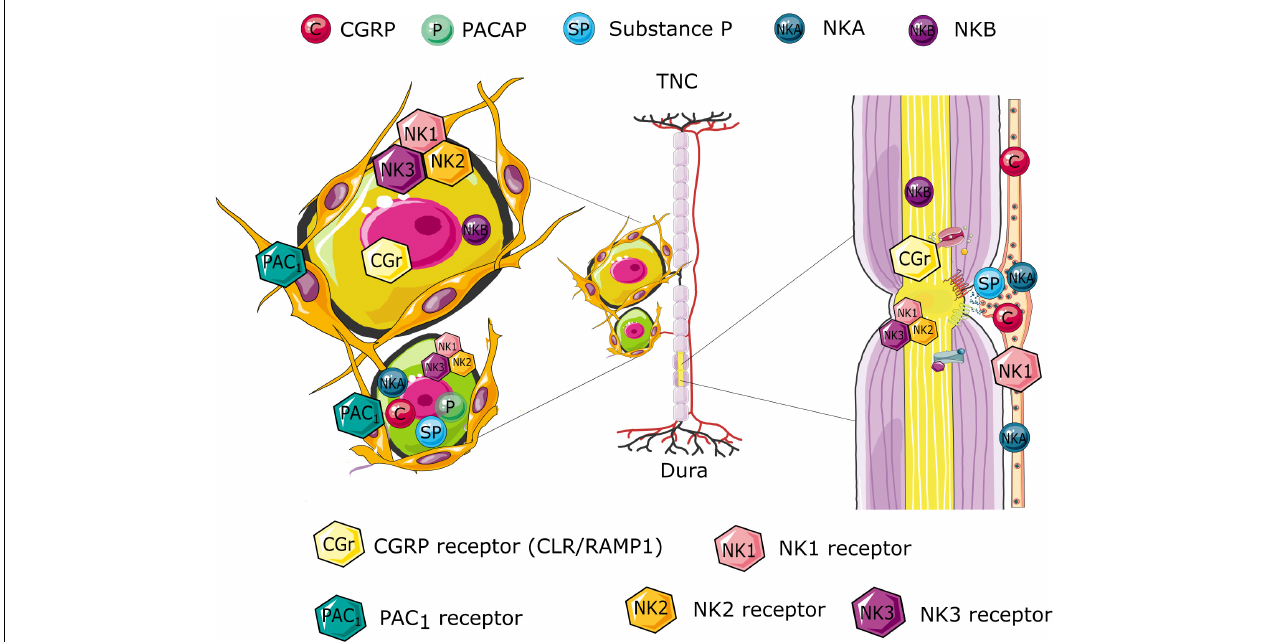
FIGURE 2 | Schematic illustration of the differential distribution of the CGRP, pituitary adenylyl cyclase-activating polypeptide (PACAP), and Neurokinin signaling compounds in the trigeminal system. The illustration suggests possible site of origin if the various peptides and their associated release. Further, the receptor expression highlights possible receptor targets, following the peptide release. The expression is based on immunology findings from the following studies (Edvinsson et al., 2019, 2021; Edvinsson J. C. A. et al., 2020; Edvinsson L. et al., 2020).